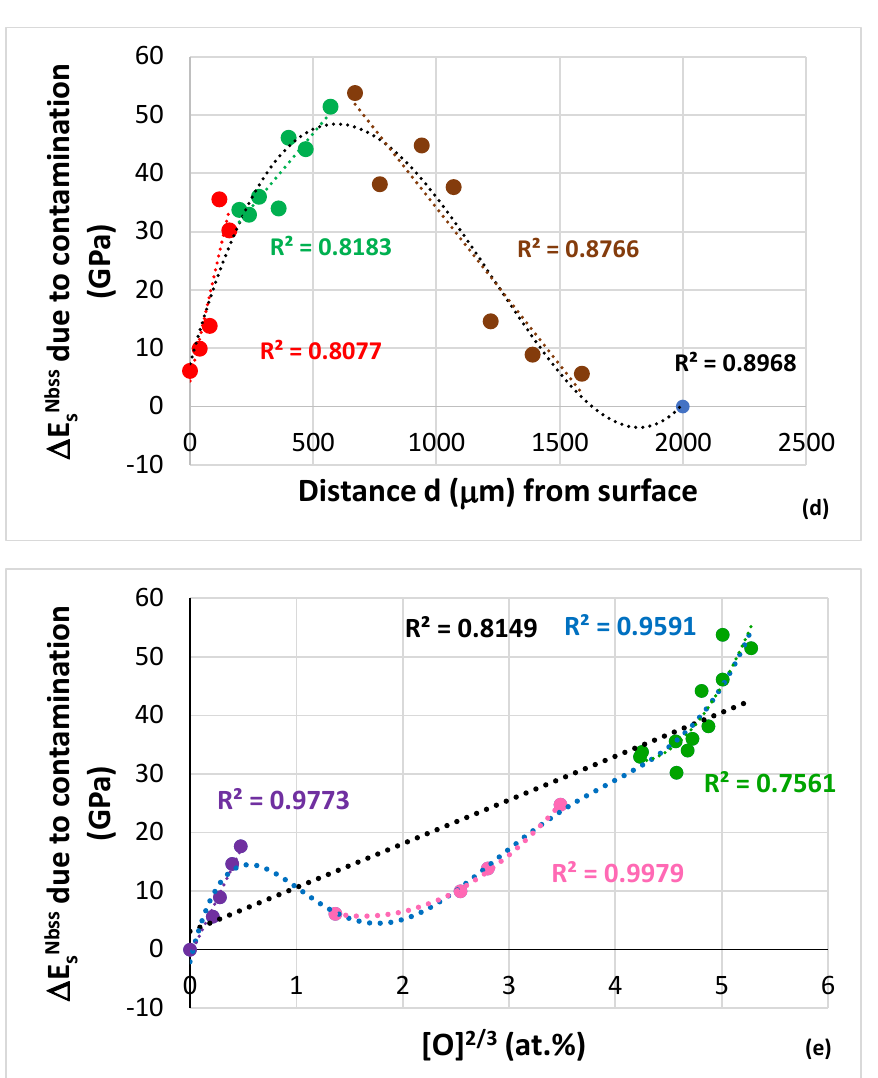
Figure 14. Data for the bcc solid solution Nb ss in the alloy NV1-HT. ( a , b ) change in solid solution hardness, respectively, with distance below the surface and with oxygen contamination. ( c , e ) de- pendence on oxygen contamination, respectively, of the nanoindentation Young’s modulus and its change with oxygen concentration. ( d ) Change in nanoindentation Young’s modulus because of contamination with oxygen with distance below the surface. In ( b , e ) the black and blue dashed lines, respectively, are for linear and polynomial fit of all data.